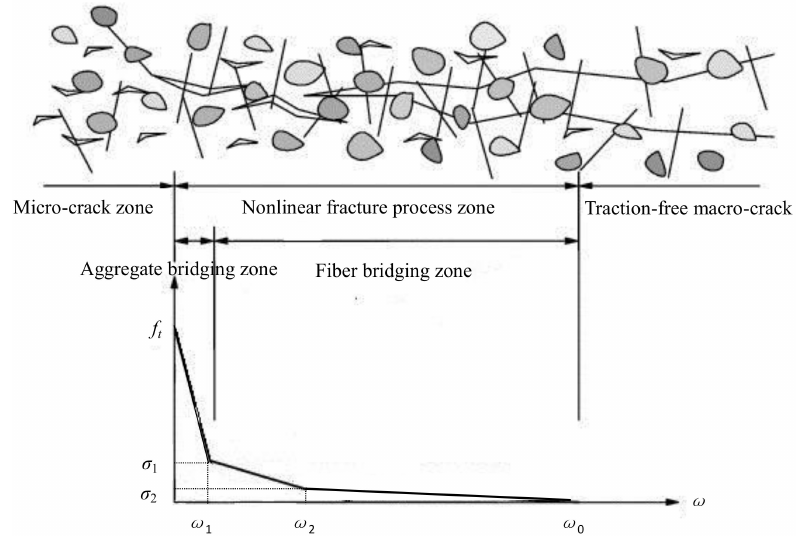
Figure 12. Trilinear softening traction-separation